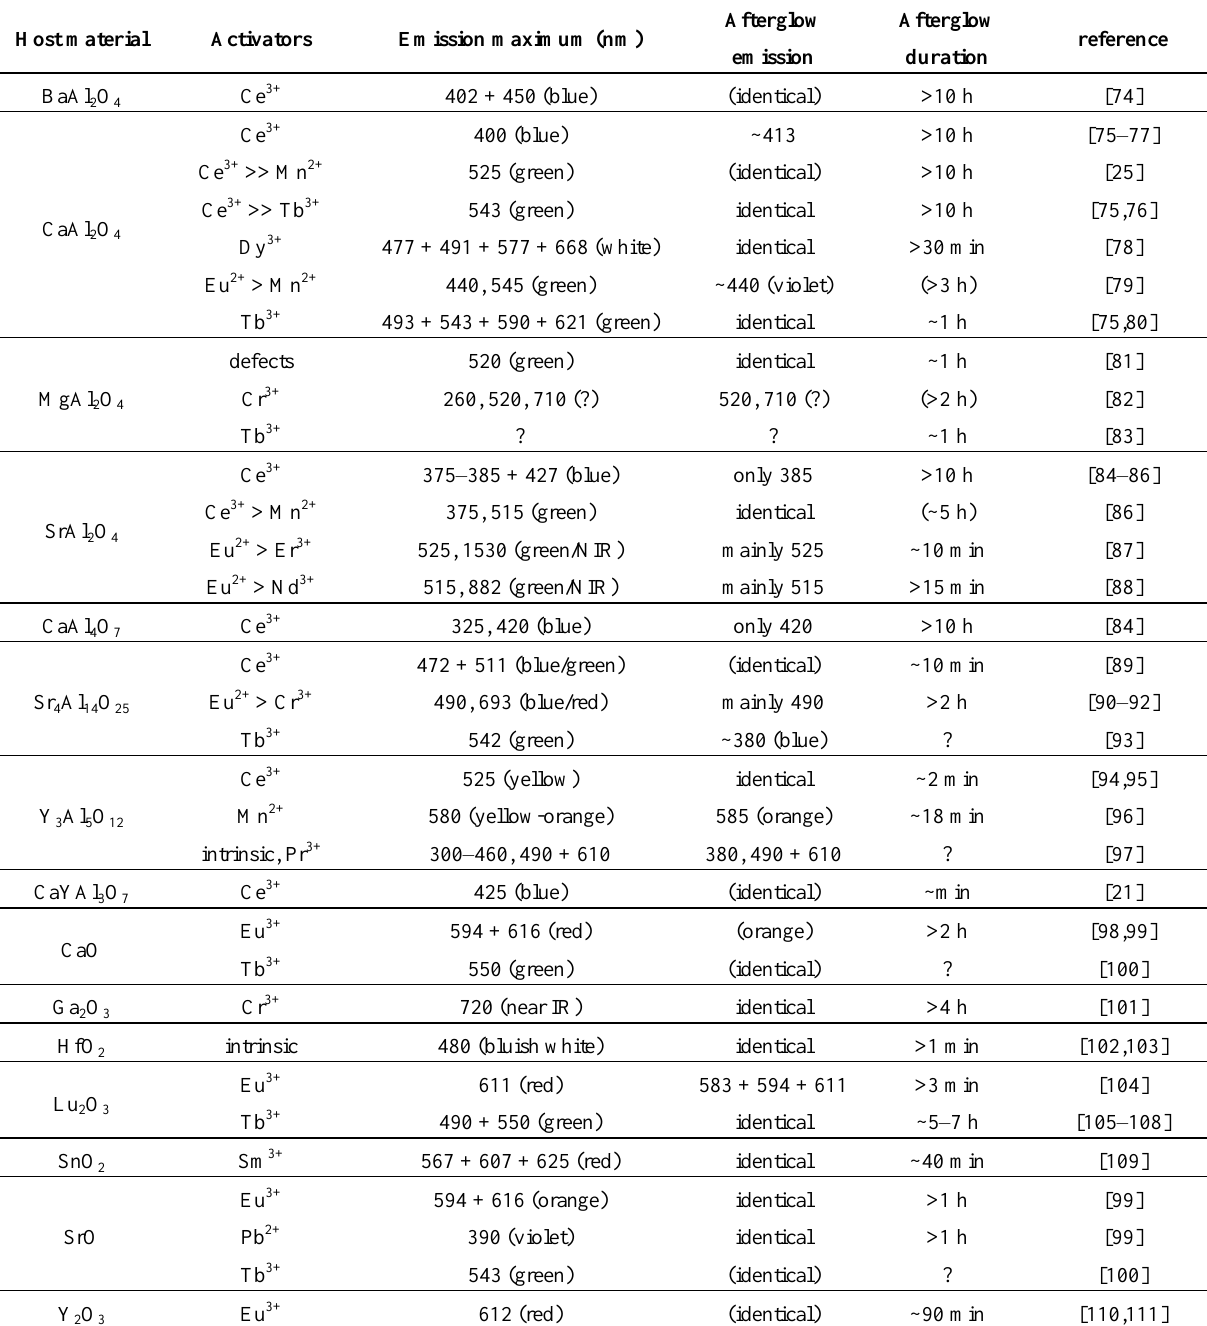
Other known non-Eu 2+ -based persistent luminescent oxides (STE = self-trapped